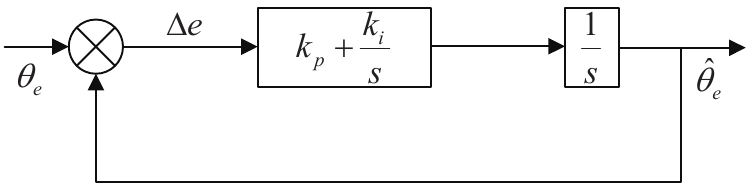
Figure 4. Traditional PLL equivalent